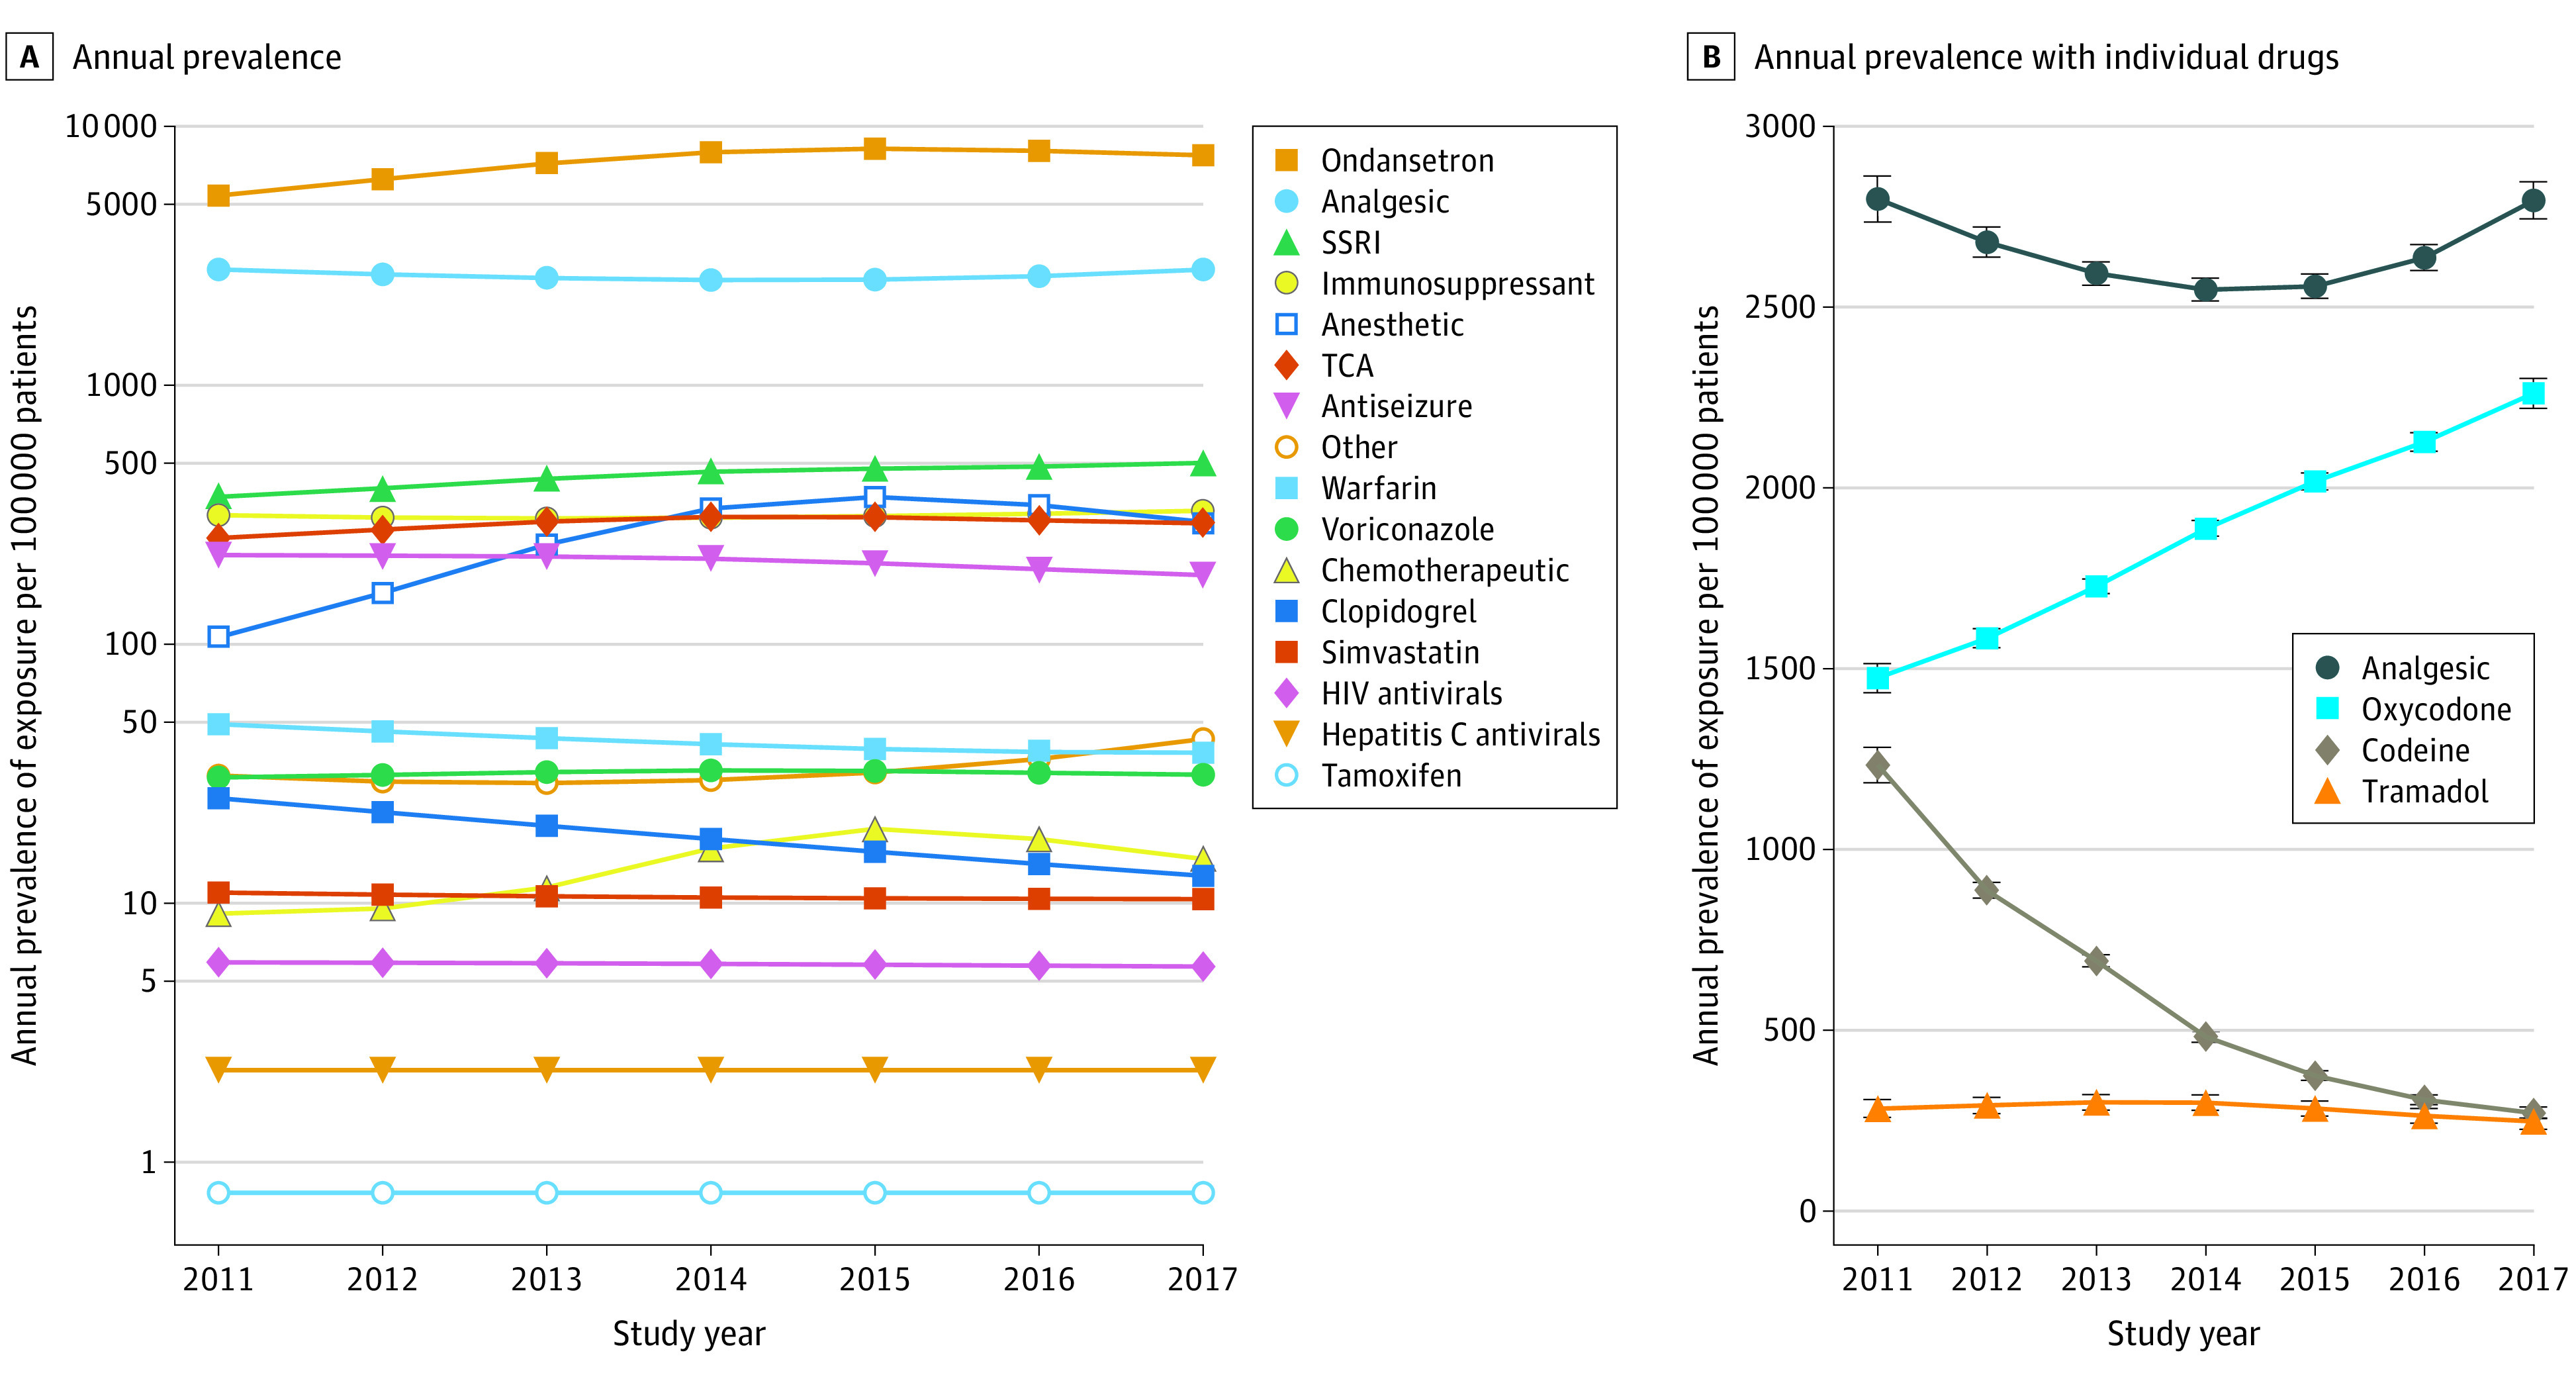
Annual Prevalence of Exposure to Clinical Pharmacogenetics Implementation Consortium (CPIC) Level A Medications, Stratified by Drug Class and Individual Analgesics A, The annual prevalence of exposure for each drug or drug class was estimated from the model and is plotted on a log axis. If a drug class only had a single included drug, that drug was listed instead of the drug class. For example, ondansetron is listed instead of antiemetic medications. B, Annual prevalence of exposure for analgesics is plotted on a linear scale. The estimated prevalence of exposure for all analgesics was taken from the drug class model in part A, whereas those for oxycodone, codeine, and tramadol were taken from the individual drug models. The whiskers indicate 95% CIs. Non-CPIC level A analgesics were not included. SSRI indicates selective serotonin reuptake inhibitor; TCA, tricyclic antidepressant.